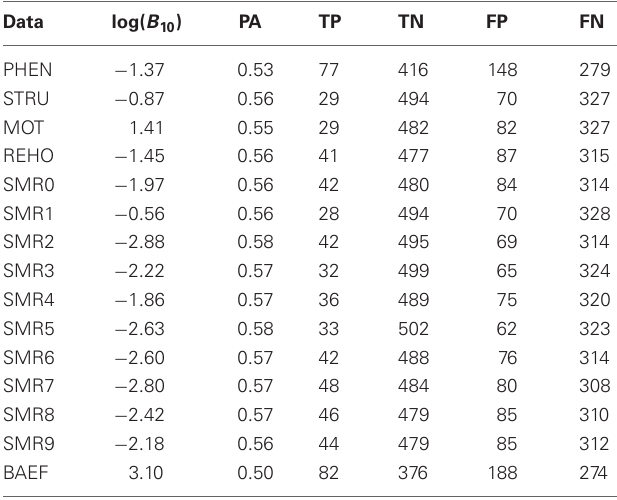
Table 5 | Single source leave-one-site-out cross-validation. Data